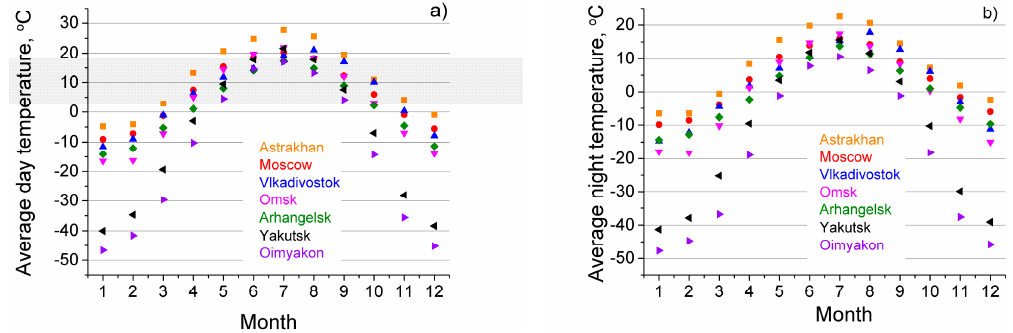
Figure 3. Average day ( a ) and night ( b ) temperatures for the climatic RF regions selected.